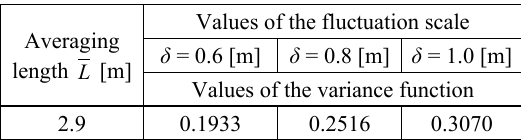
Table 8. Values of variance function for three different values of fluctuation scale